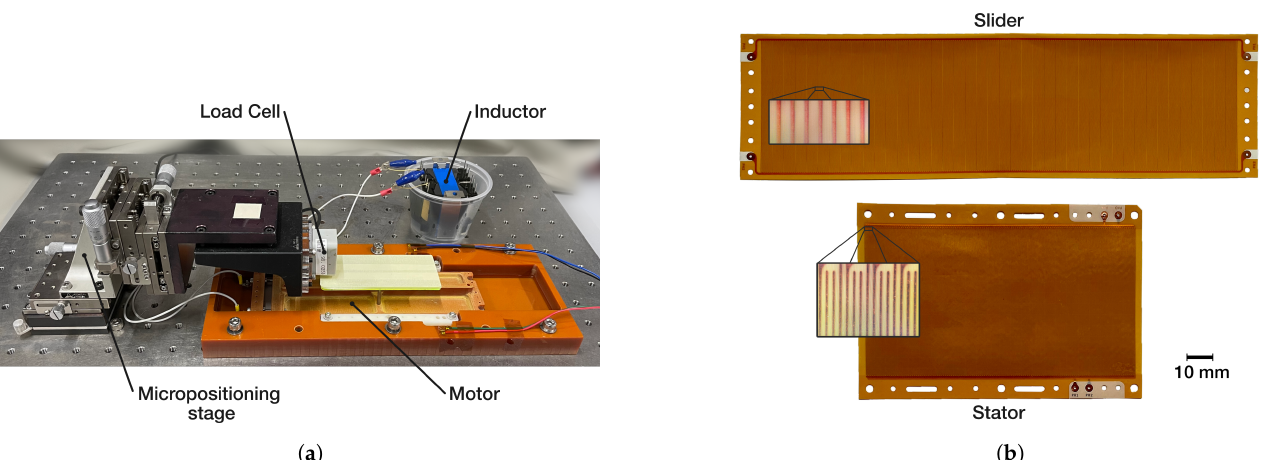
Figure 7. Experimental setup used for force measurement. ( a ) Prototype motor and load cell assembly. ( b ) Pictures of the used films, highlighting the electrode